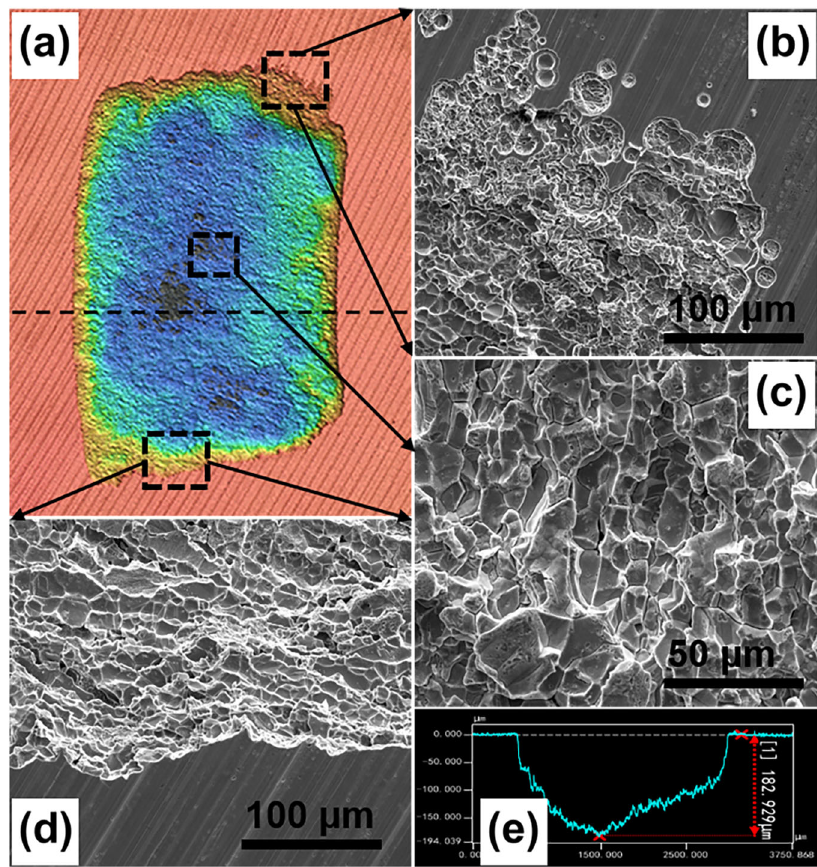
Fig. 7 Arti fi cial crevice corrosion morphologies of 2507 SDSS after immersing for 36 months. a pro fi le of the whole crevice area, b – d local magni fi cation of different corrosion zones, e topographic pro fi le of cross-section.